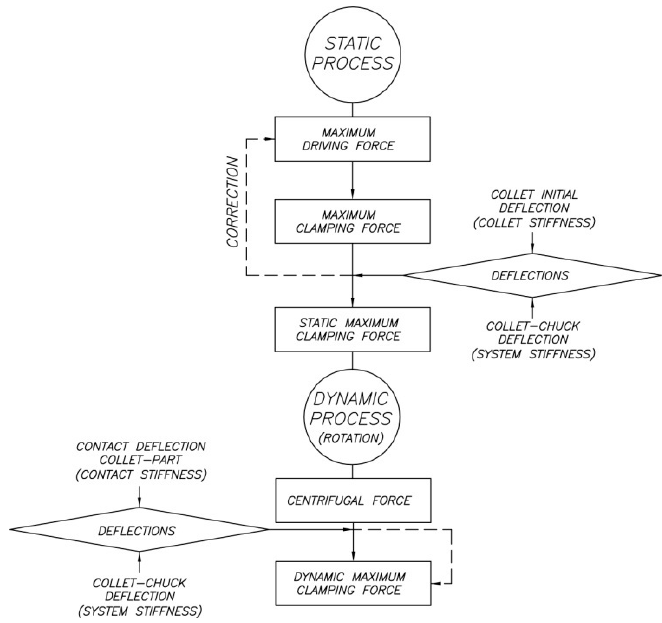
Figure 4. Sequence of the mechanical analysis.